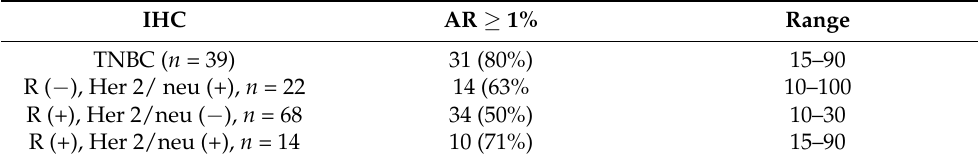
Table 1. The distribution of AR+